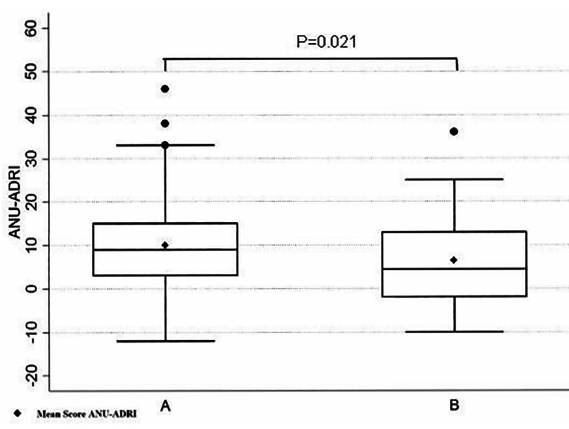
Figure 3. Bland-Altman plot for the two measurements of the ANU-ADRI . Figure 4. Box – Plot of the ANU-ADRI by groups (A and B).